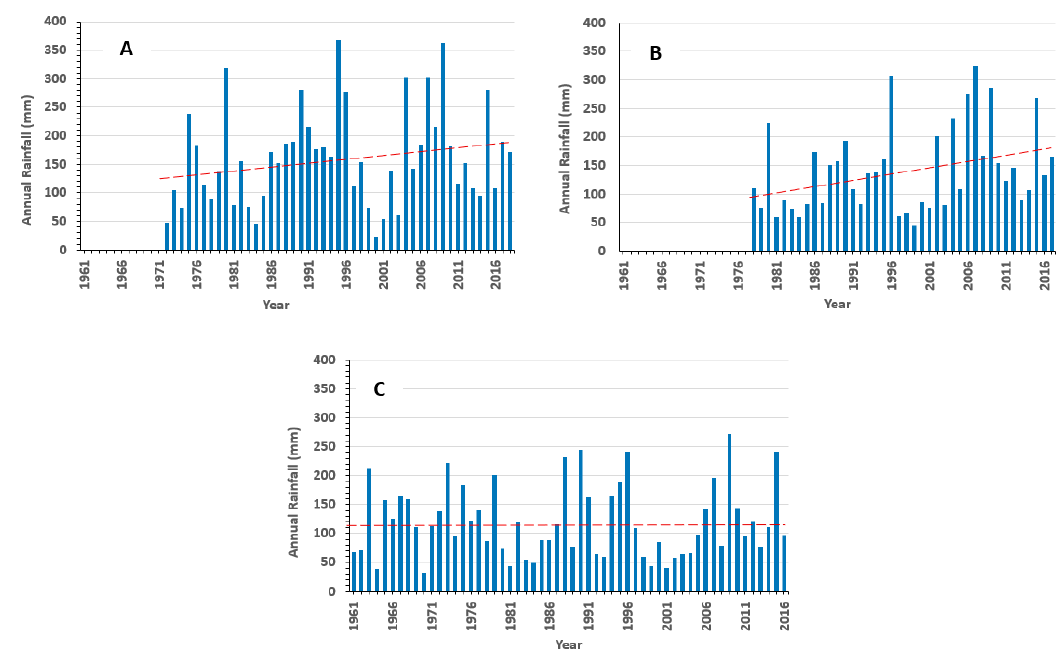
Figure 8. Annual rainfall and linear trend (red dotted line) at Ait Haddou ( A ), Tit N’Aissa ( B ) and Bouanane ( C ) stations, for measurements over 1972–2018, 1977–2018 and 1959–2018 periods, respectively. Trend lines are linear models.